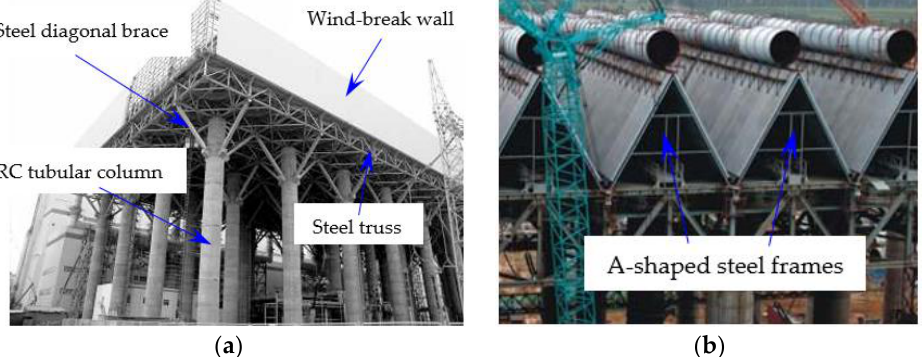
Figure 1. Photos of a practical supporting structure with diagonal braces: ( a ) Global structure; ( b ) A-shaped steel frames resting on the steel truss.